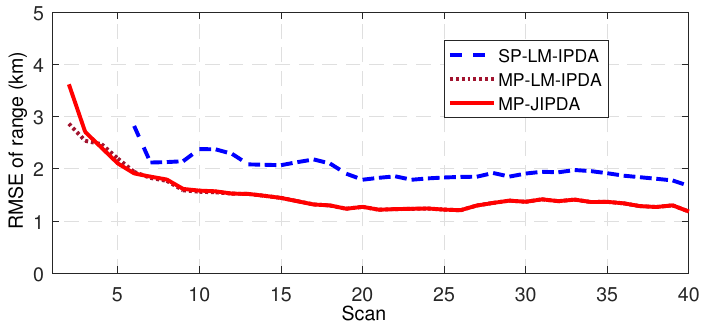
Figure 6. RMSE of range for Target 3.